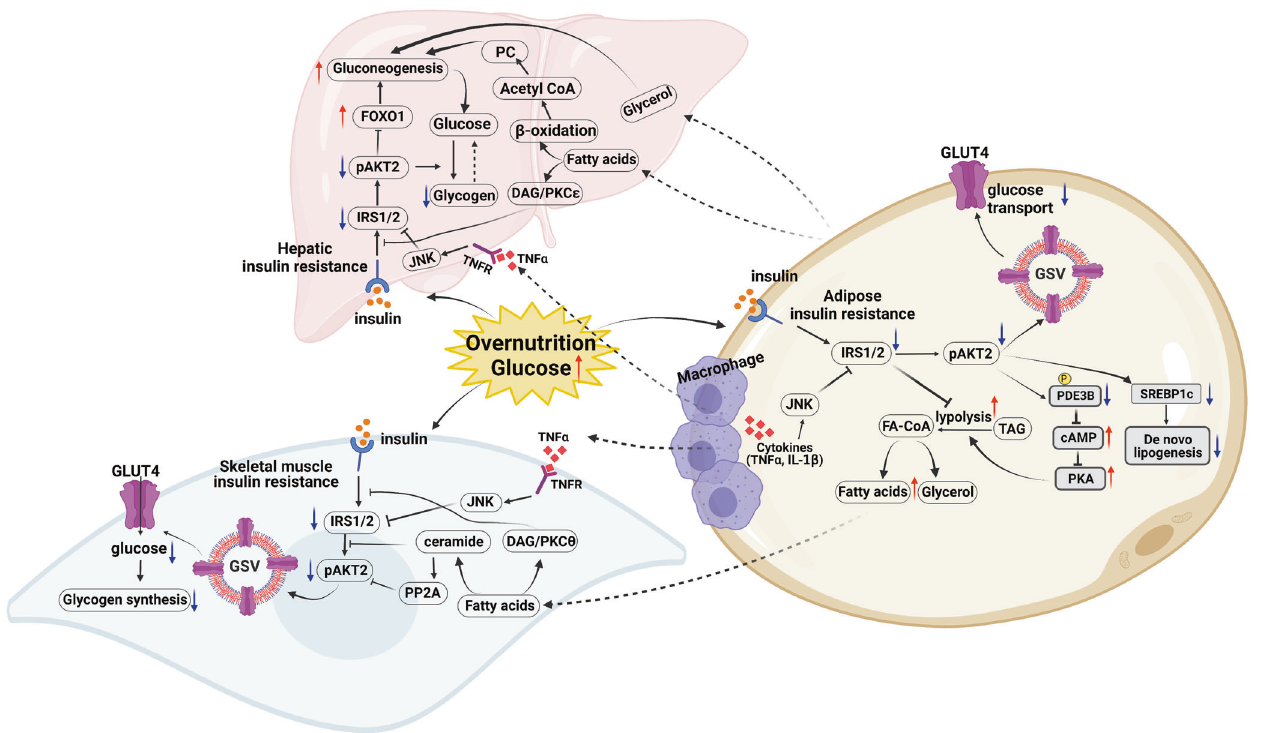
Fig. 3 An integrated physiological signaling on different target tissues insulin